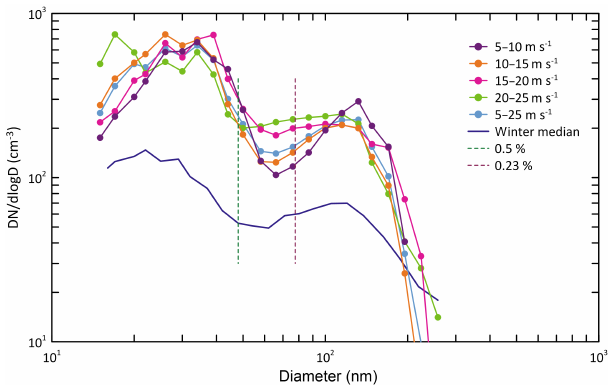
Figure 3. DMA-derived size distribution including Aitken- accumulation/CCN mode gap as a function of wind